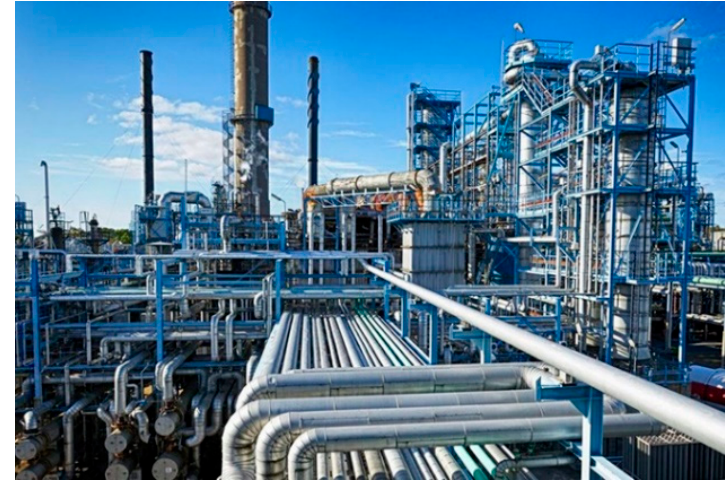
Figure 1. Fluorochemical pipeline.